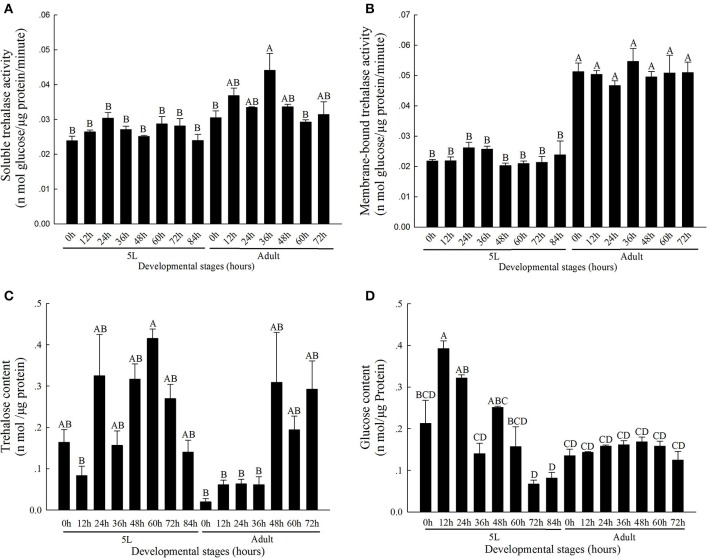
Soluble trehalase (A), Membrane-bound trehalase activity (B), and trehalose (C), and glucose (D) levels in N. lugens at different developmental stages from 0 h in 5th instar nymph to 72 h in adults. All of N. lugens 5th instar nymph and adults were selected every 12 h, and insects were collected and used to detect the activities of the two kinds of trehalase isoenzymes and measure the trehalose and glucose levels. Every group had three to five replicates. The age of the brown planthoppers was defined as follows: 5L-0, 0 h fifth-instar nymph; 5L-12, 12 h fifth-instar nymph; 5L-24, 24 h fifth-instar nymph; 5L-36, 36 h fifth-instar nymph; 5L-48, 48 h fifth-instar nymph; 5L-60, 60 h fifth-instar nymph; 5L-72, 72 h fifth-instar nymph; 5L-84, 84 h fifth-instar nymph; A-0, 0 h adults; A-12, 12 h adults; A-24, 24 h adults; A-36, 36 h adults; A-48, 48 h adults; A-60, 60 h adults; and A-72, 72 h adults. (Tukey's test, α = 0.05, A>B>C>D).